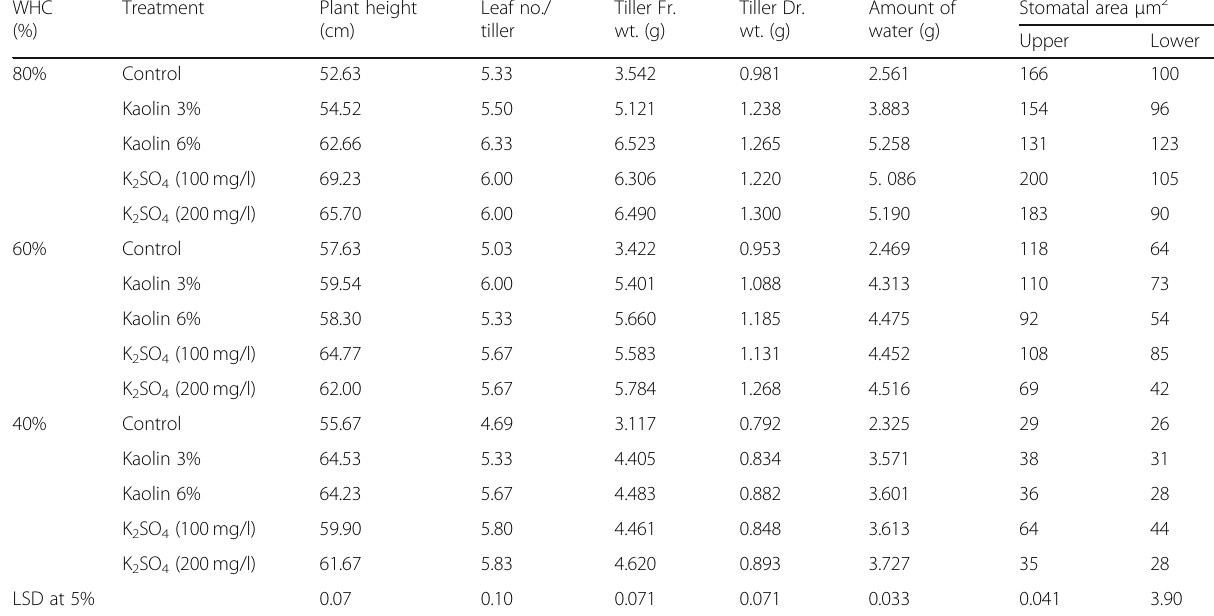
Table 2 Effect of different concentrations of kaolin or K criteria and area of stomata (upper and lower epidermis) of wheat plants after 75 days from sowing combined analysis of two